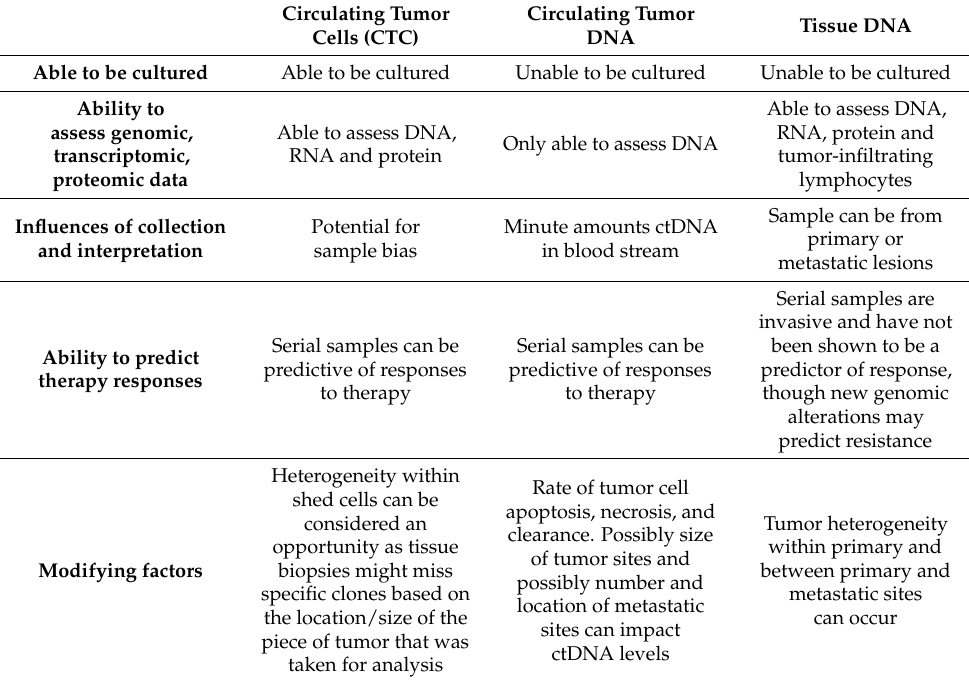
Table 1. Comparison of CTCs, circulating tumor DNA (ctDNA), and tissue DNA (tDNA).